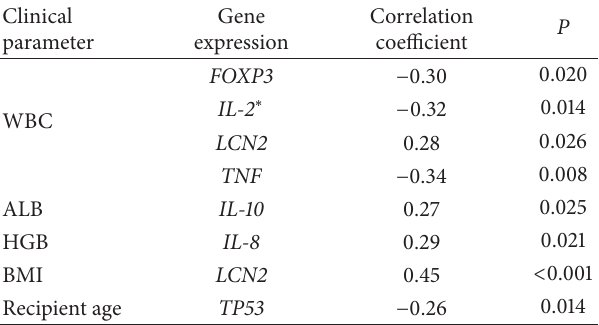
Table 4: Significant correlations between pretransplant clinical parameters and gene